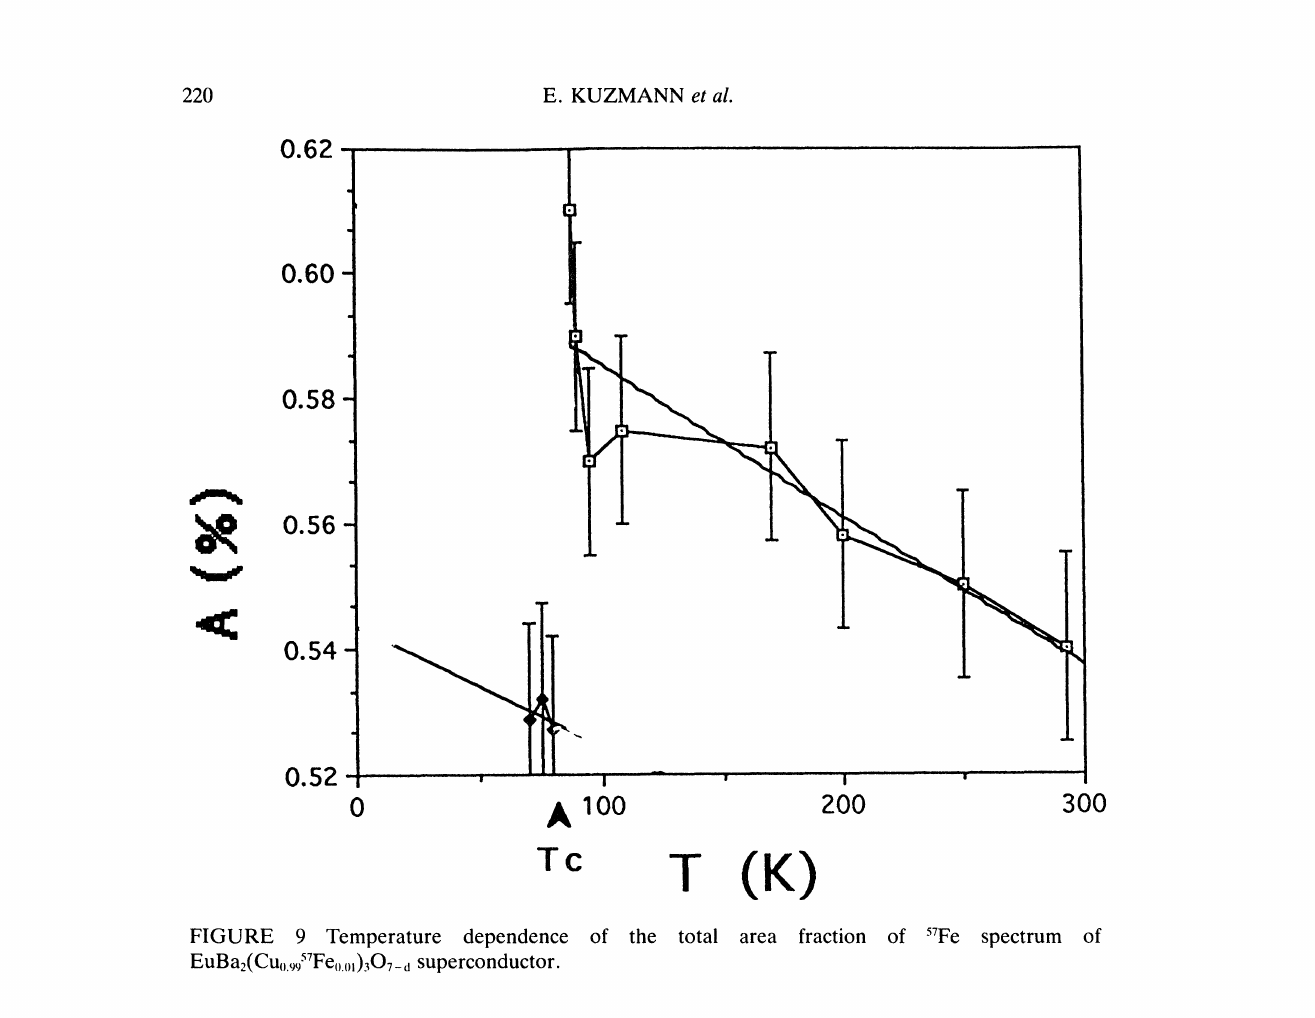
EuBaz(Cuo.99-VFeo.o)3OT_d